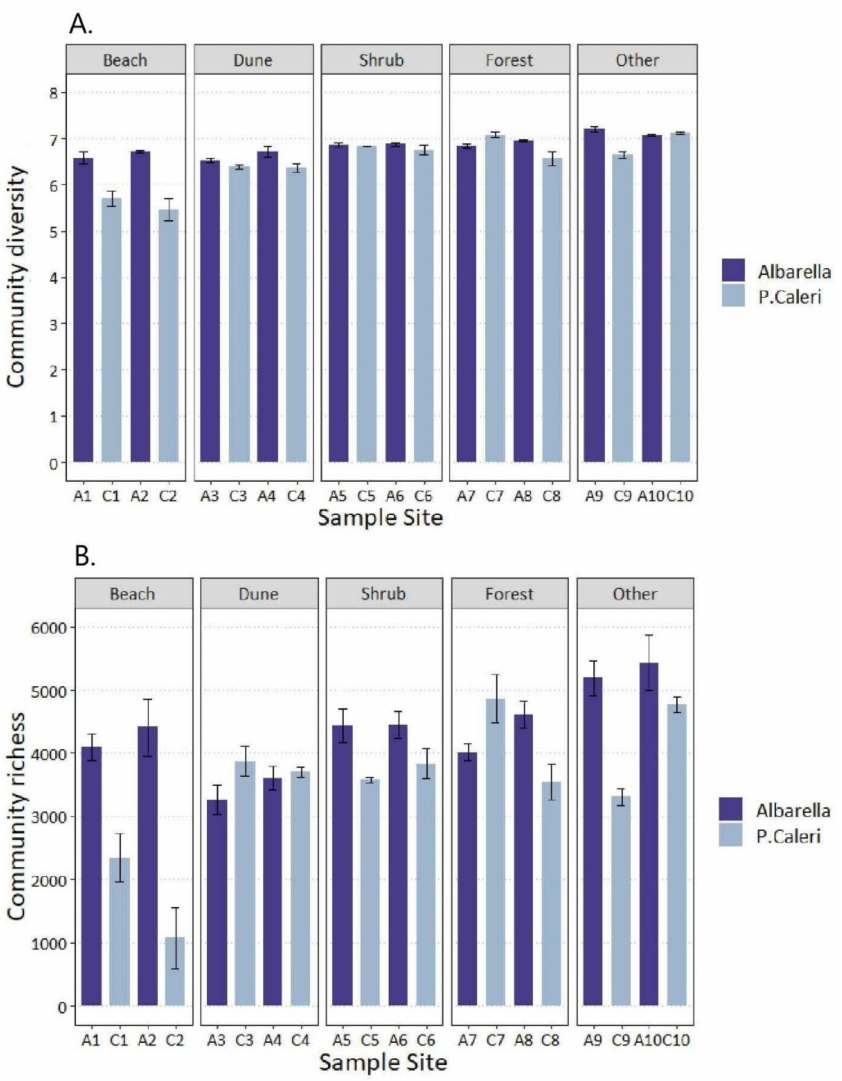
Figure 4. Soil bacteria diversity at the I level. Values shown in the figure are means of ( A ) Shannon– Wiener and ( B ) Chao1 indices; vertical bars are SE (n =